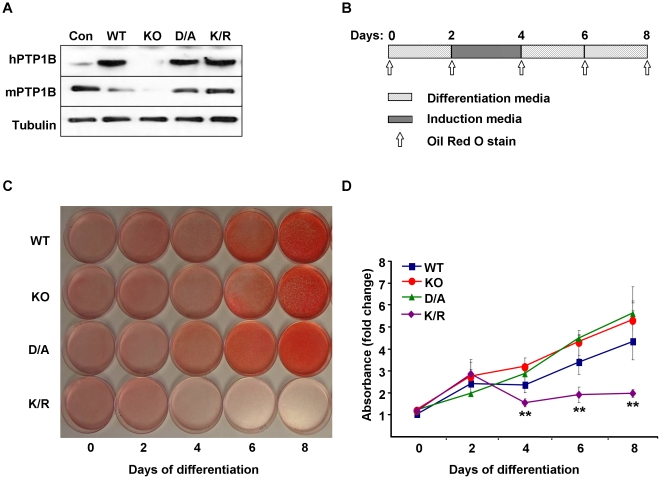
PTP1B regulates brown adipocyte differentiation.
A) Immunoblots of human (h) and mouse (m) PTP1B expression in immortalized brown adipocytes from wild type mice (Con), PTP1B knockout (KO) mice, and KO cells reconstituted with hPTP1B (WT), substrate-trapping (D/A), and sumoylation-resistant (K/R) hPTP1B mutants. Blots were probed with anti-Tubulin antibodies as a control for loading. B) Schematic depicting timeline of cell differentiation and oil red O staining. C) Brown adipose precursor cells were grown to confluence, then differentiation was induced as described in Methods. At various stages of differentiation, cells were fixed and stained with oil red O, then the dye was extracted and its absorbance (520 nm) quantitated (D). Graph represents data from nine independent experiments, and data are expressed as mean ± SEM. (**) indicates significant difference between K/R and WT, KO and D/A cells.